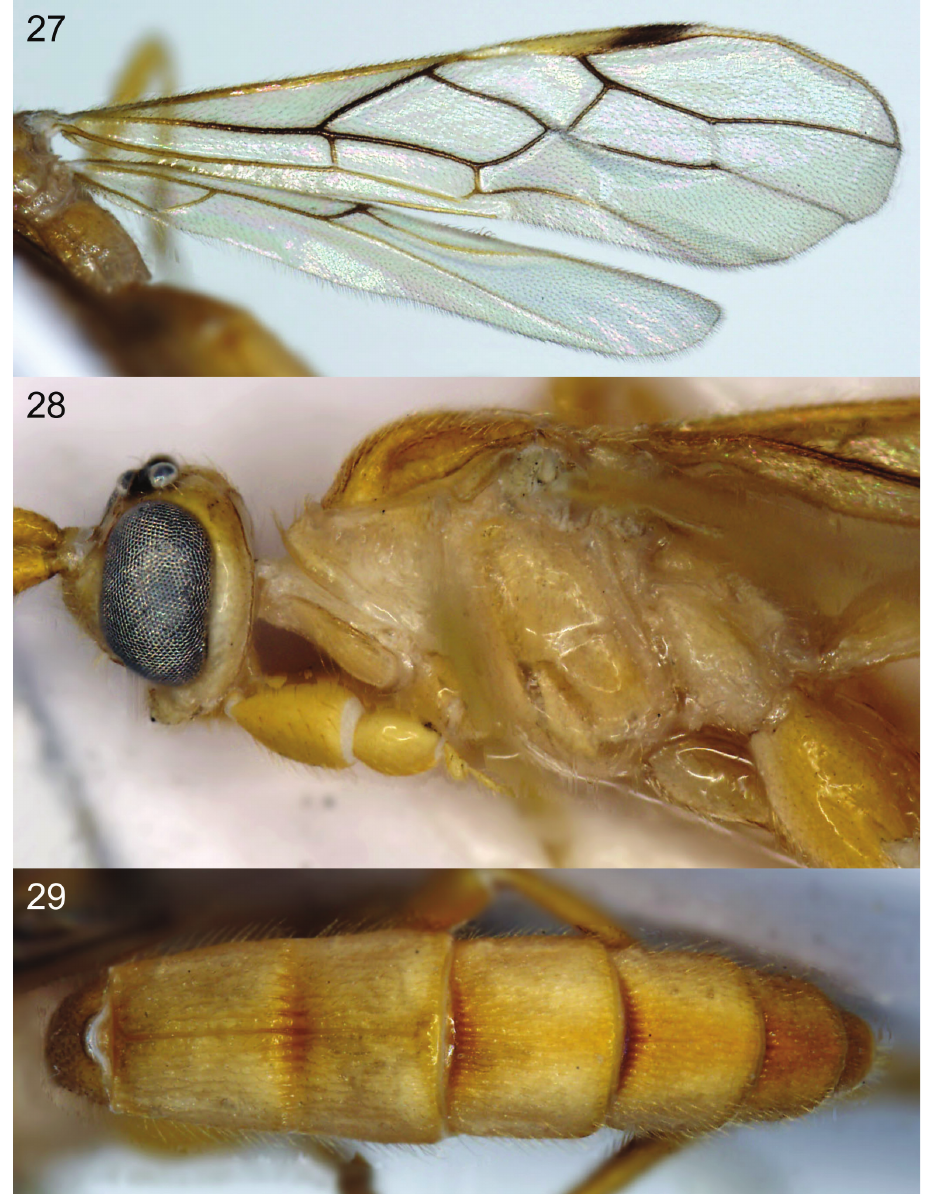
Figures 27–29. Colastomion crambidiphagus sp. n. holotype, Cell^D® light photomicrographs. 27 Wings 28 head and mesosoma, lateral view 29